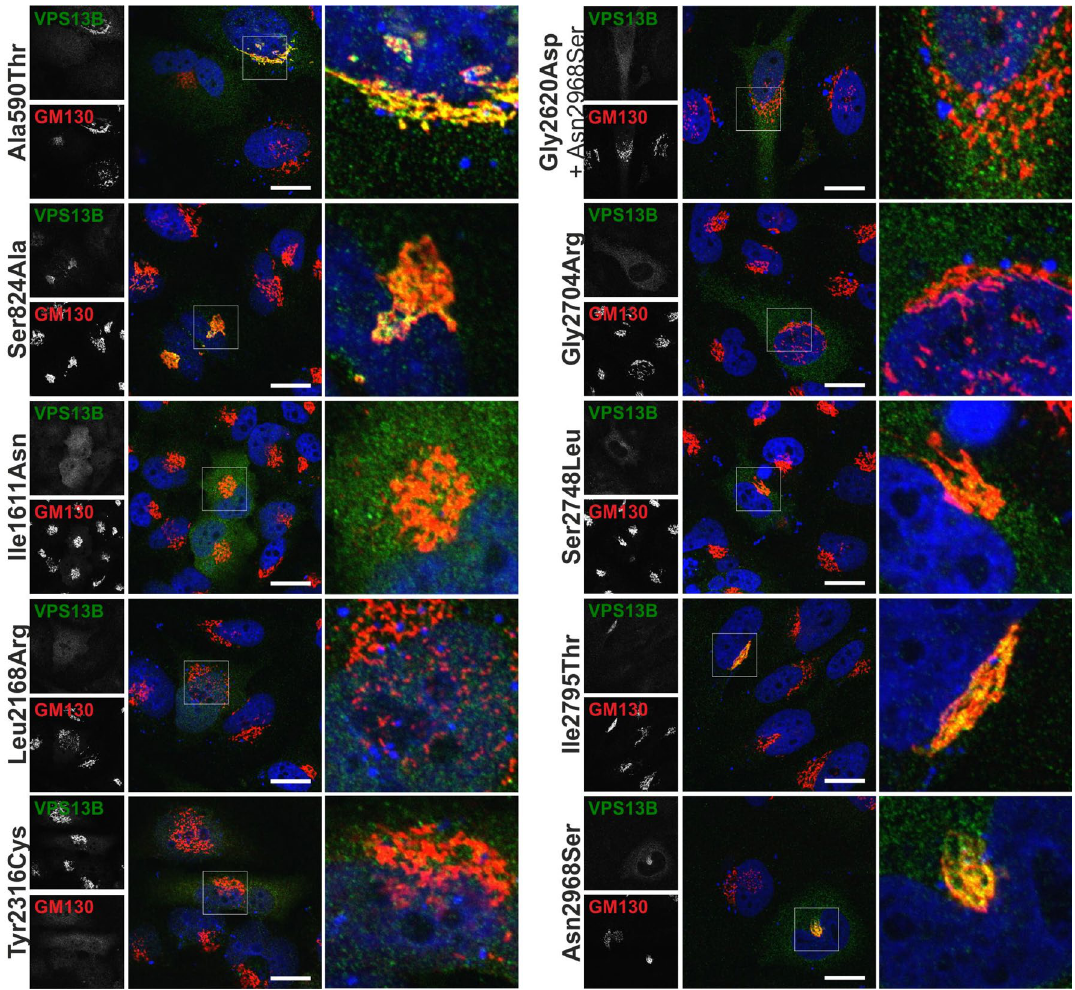
Figure 3. Rescue experiment of Golgi fragmentation by co-overexpression of VPS13B missense variants. HeLa cells were transfected with a VPS13B -specific RNAi (siRNA #25721, ambion). 48 h post RNAi-transfection HeLa cells were transfected with the respective pcDNA3.1_VPS13B-mut constructs. 24 h later, cells were processed for immunostaining of VPS13B (green) and GM130 (red). Imaging occurred with confocal microscopy. Nuclei were stained using DAPI, scale bars 10